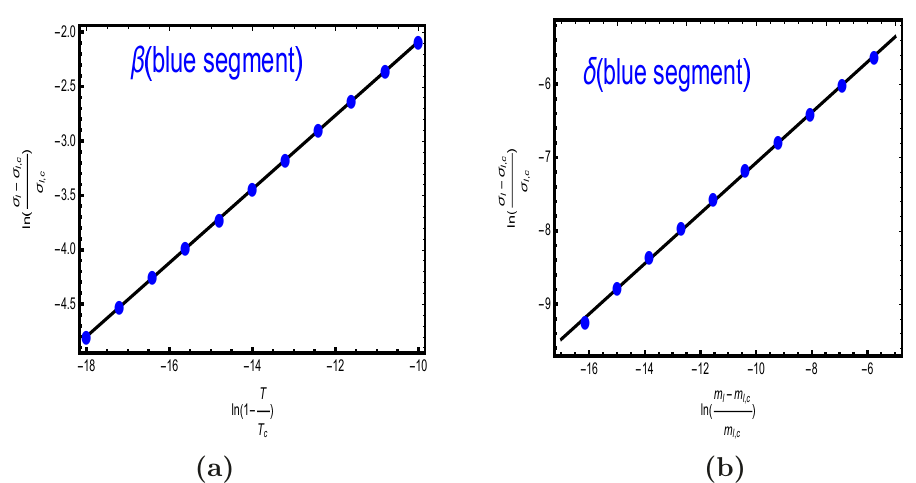
Figure 10 . Temperature and quark mass dependence of chiral condensate near the criti- cal point T l,c 2 = 0 . 19123136679 . . . GeV , m l,c 2 = 0 . 010 GeV , m s , c2 = 0 . 120105 . . . GeV , σ l , c2 = 0 . 0271 . . . GeV 3 , σ s , c2 = 0 . 0232 . . . GeV 3 , which locates at the blue segment of the chiral crit- T ) as a function of ln(1 ), with fixed quark mass ical line. Panel.(a) gives ln( σ l − σ l,c 2 σ l,c 2 T l,c 2 − m l = m l,c 2 = 0 . 010 GeV , m s = m s , c2 = 0 . 120105 . . . GeV. The blue dots are model calculation and the black solid straight line are linear fitting of the dots, which has the form y = 1 . 304 + 0 . 339 x . Panel.(b) gives ln( σ l − σ l,c 2 ) as a function of ln( m l − m l,c 2 ). The blue dots are model calculation and σ l,c 2 m l,c 2 the black solid straight line are linear fitting of the dots, which has the form y = 3 . 63952+0 . 343 x . −